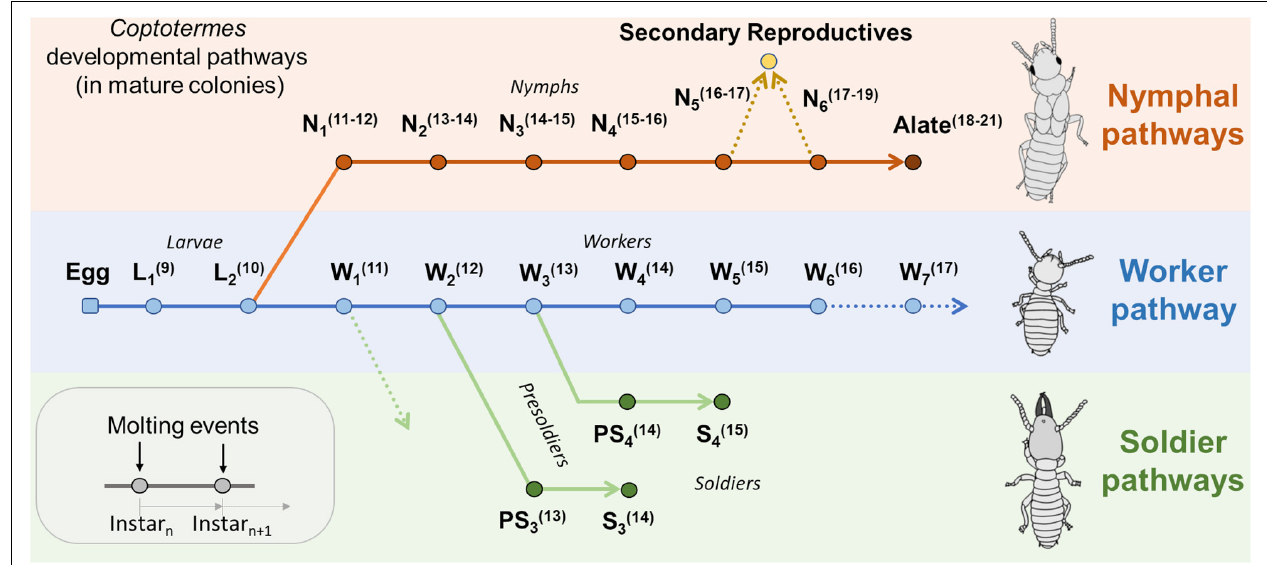
FIGURE 1 | Developmental pathways expected in mature colonies of Coptotermes formosanus , modified from Chouvenc and Su (2014). L n , Larva instar; W n , Worker instar; N n , Nymph instar; PS n , Presoldier type, and S n , Soldier type. Values in parenthesis ( n ) indicate the expected number of antennomeres for each given